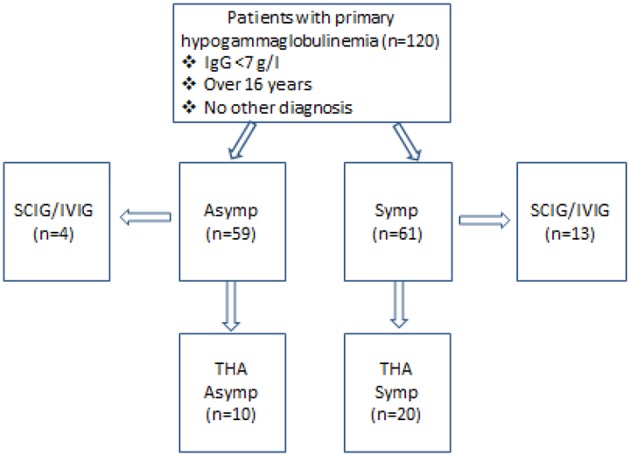
Characteristics of patients enrolled in this study. Fifty-nine patients were asymptomatic while 61 had symptoms, which could be attributed to the immune defect. Thirteen symptomatic (Symp) and four asymptomatic (Asymp) patients were accepted for SCIG/IVIG. THA-transient hypogammaglobulinemia of adulthood, with IgG increasing to ≥7.0 g/l.